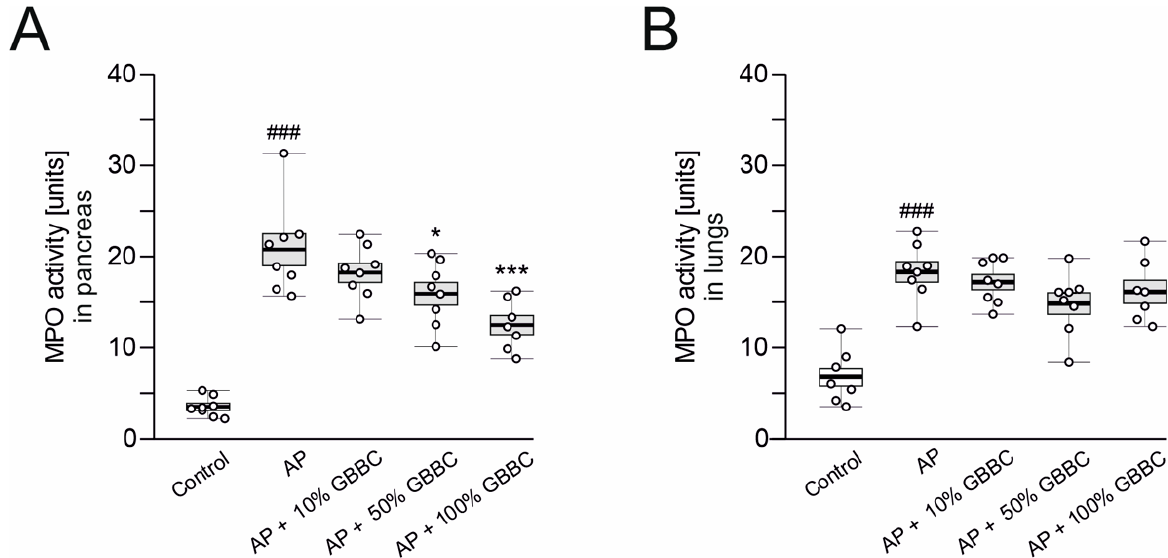
Figure 1. MPO activity in pancreas ( A ) and lungs ( B ) of healthy mice, mice with evoked acute pancreatitis (AP), and mice with AP after administration of increasing concentration of ghee butter from bovine colostrum (GBBC). Data presented as raw data (circles) and means (horizontal bolded lines) with SEM (boxes). The significance was calculated using one-way ANOVA and Dunnett’s post hoc test. n = 7–8; # (hash) denotes comparison to control. * (asterisk) indicates comparison to AP (acute pancreatitis). #/* denotes p < 0.05; ##/** denotes p < 0.01; ###/*** denotes p < 0.001. 3.2. Administration of GBBC Significantly Reduced Lipase Activity but Not Amylase Activity in the Blood Serum in L-Arginine-Induced AP in Mice Elevated plasma amylase and lipase are important markers of pancreatic acinar cell injury [27,28]. Administration of L-arginine increased amylase and lipase activity in the blood serum compared to controls (amylase: 5563 ± 380 vs. 4506 ± 154 mU/mL, Figure 2A; lipase: 4.11 ± 0.39 vs. 2.82 ± 0.28 mU/mL, p = 0.025, Figure 2B). Administration of GBBC, irrespective of concentration, did not reduce the amylase activity in the blood serum. Administration of GBBC concentration-dependently reduced lipase activity in the blood serum compared to AP mice, with a statistically significant effect observed at the concentration of 100% (2.05 ± 0.20 vs. 4.11 ± 0.40 mU/mL for 100% GBBC vs. AP mice, respectively, p = 0.021, Figure